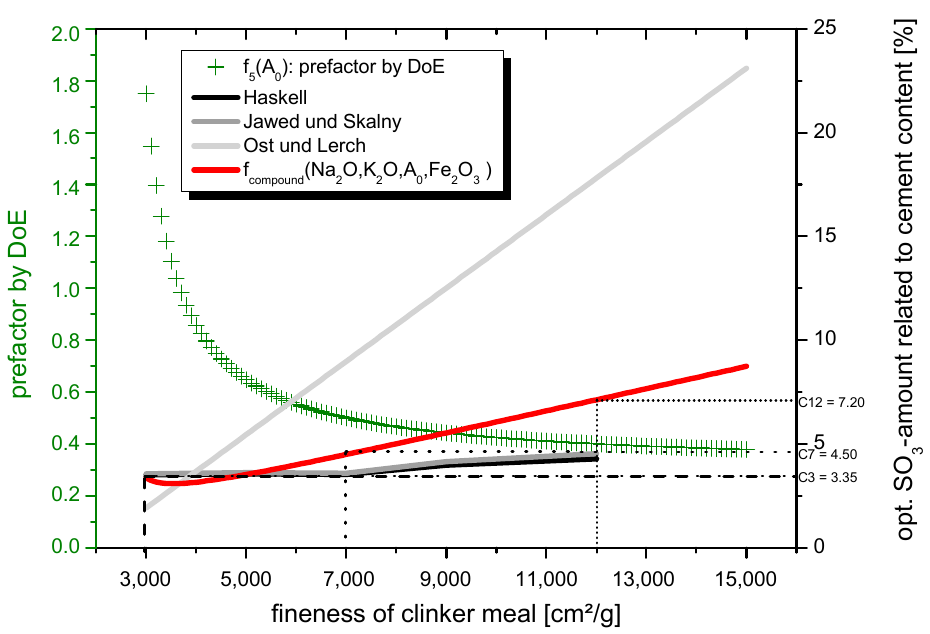
Figure 12. Diagram to determine the optimum SO 3 -amount in dependency of the grinding fineness of clinker meal.